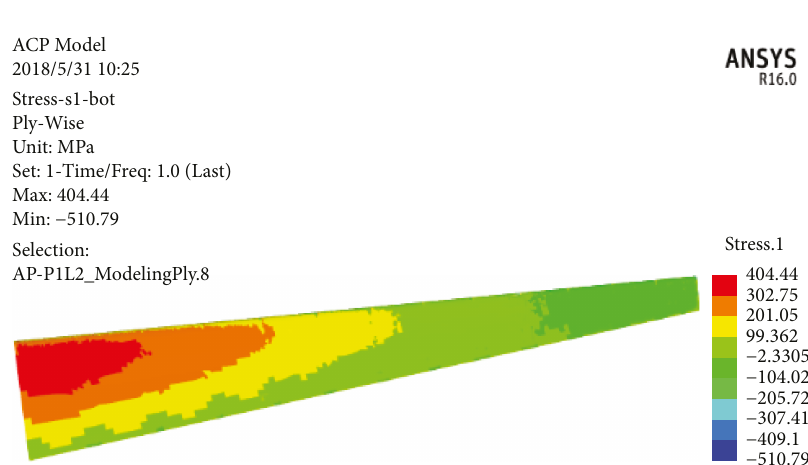
Figure 55: Stress cloud diagram of the lower wing with the layer ratio being 70%/20%/10%.